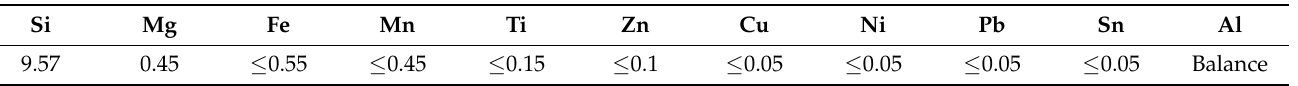
Table 3. Chemical composition of the selected SLM additively manufactured AlSi10Mg alloy